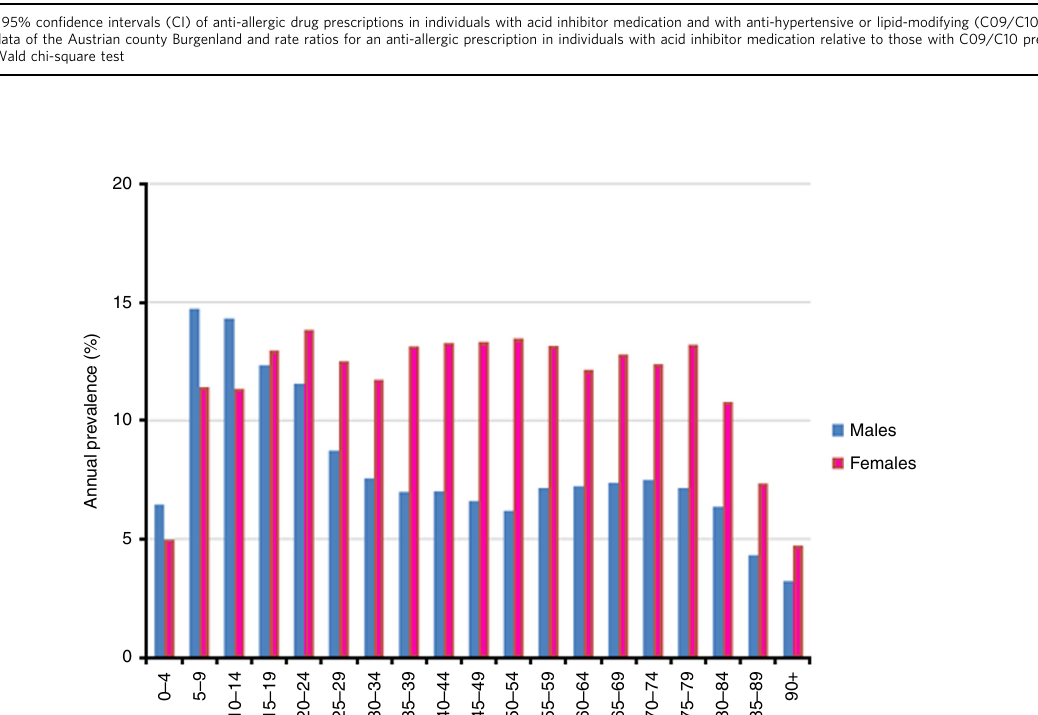
Fig. 2 Annual prevalence of anti-allergic drug prescriptions. Data presented by gender and age groups 2009 – 2013 in the Austrian county Burgenland with 977,488 person-years of Table 3). Risk of a subsequent prescription of an anti-allergic drug was, however, unaffected comparing those with and without M01 co-medication (Supplementary Fig. 4).